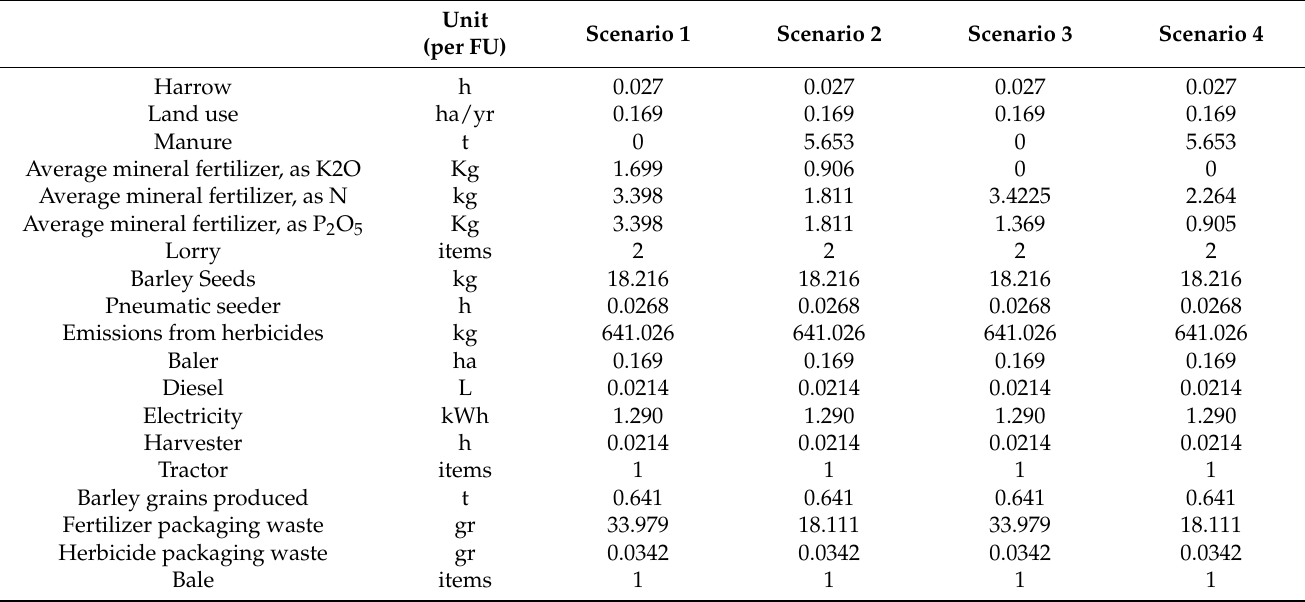
Table 2. Inventory data expressed in units/FU for each given